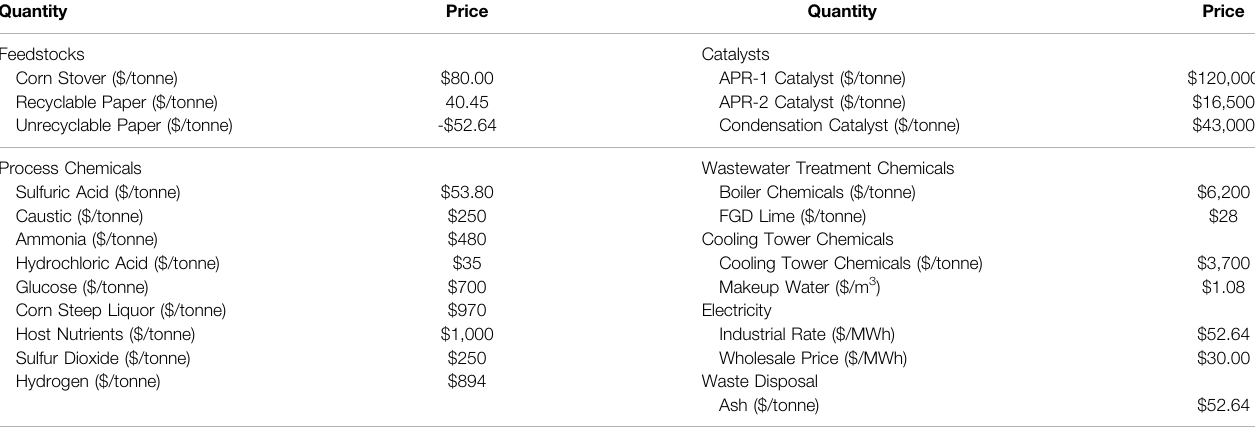
TABLE 5 | Prices for feedstocks, chemicals, catalysts, utilities, and waste disposal in USD (2020). Quantity